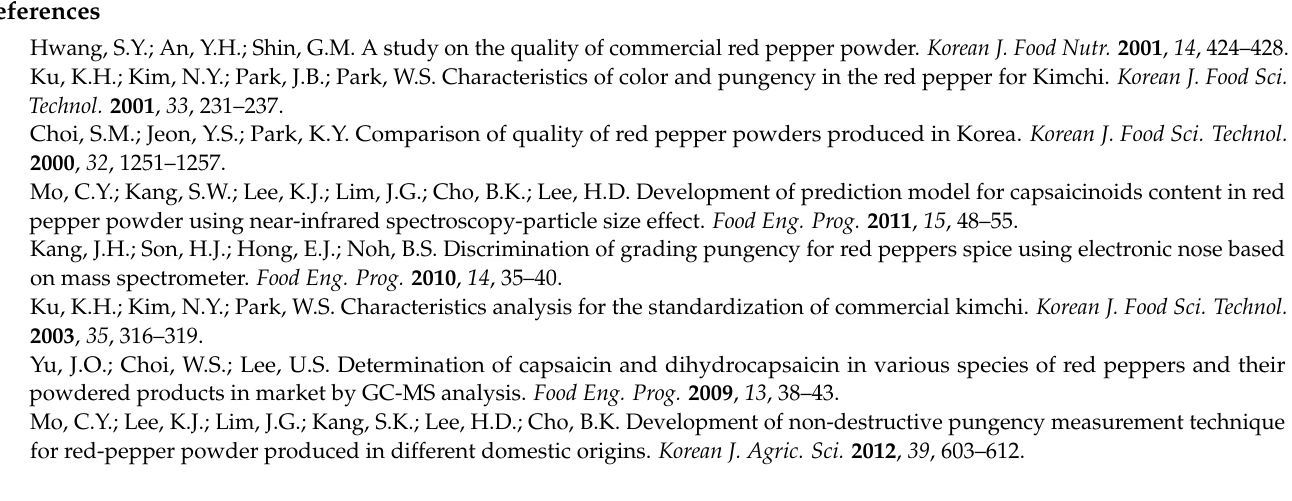
Model B is 0.839, a decrease of about 12%. As shown in Figure 5, the fact that the R p2 value